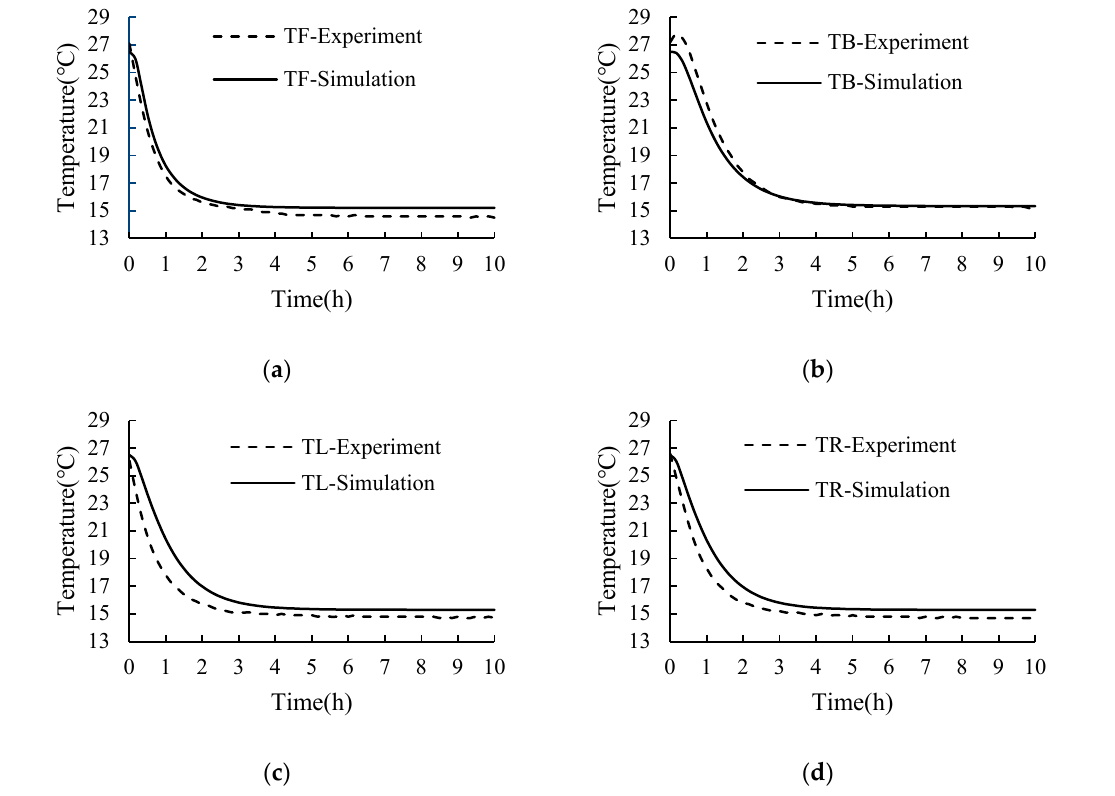
Figure 9. Comparison between the simulation values and the experiment values of the tempera- tures of fresh tea leaves in the basket: ( a ) front monitor point (TF); ( b ) back monitor point (TB); ( c ) left monitor point (TL); and ( d ) right monitor point (TR). A comparison between the simulated value and the test value of velocity at each monitor point is shown in Figure 10. The relative calculation errors between the simulated and test velocity values were obtained by the simultaneous use of Equations (10) and (11) and are presented in Table 3. The results indicate that the maximum deviation between the simulated velocity and test velocity was 0.11 m/s, the maximum RE was 29.05%, and the maximum SD was 0.024. Such a high value for the RE at certain locations may be attributed to the poor accuracy of measurements at low velocity, where a small difference induces a high relatively error [32]. Moreover, one restriction of the sensor is that it can only measure the velocity in one direction without considering the anisotropy of airflow.